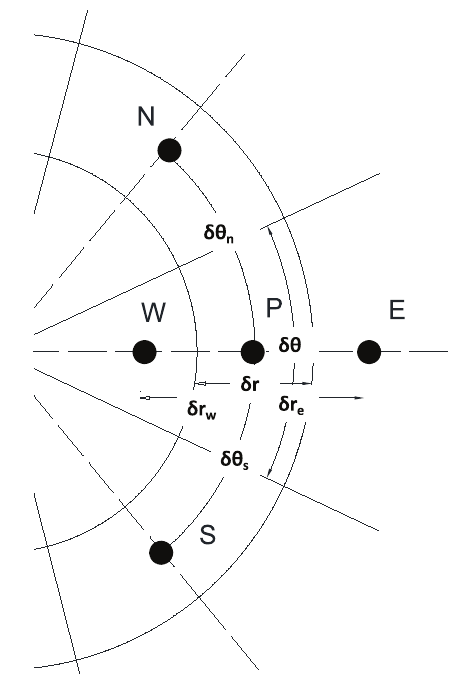
Figure 1. Schematic of a two-dimensional control volume used in the development of the numeric model. Stems are divided into uniform angular wedges and each wedge is discretized into nodes (e.g. P,N,S,W, E) in the radial direction. The distance between nodes is flexible (e.g. d r w) , and was set in the simulations described in this study to 1 mm. d r e : distance of W from P , d r w : distance of E from P , dh n : angular distance of N from P , dh s : angular distance of S from P .